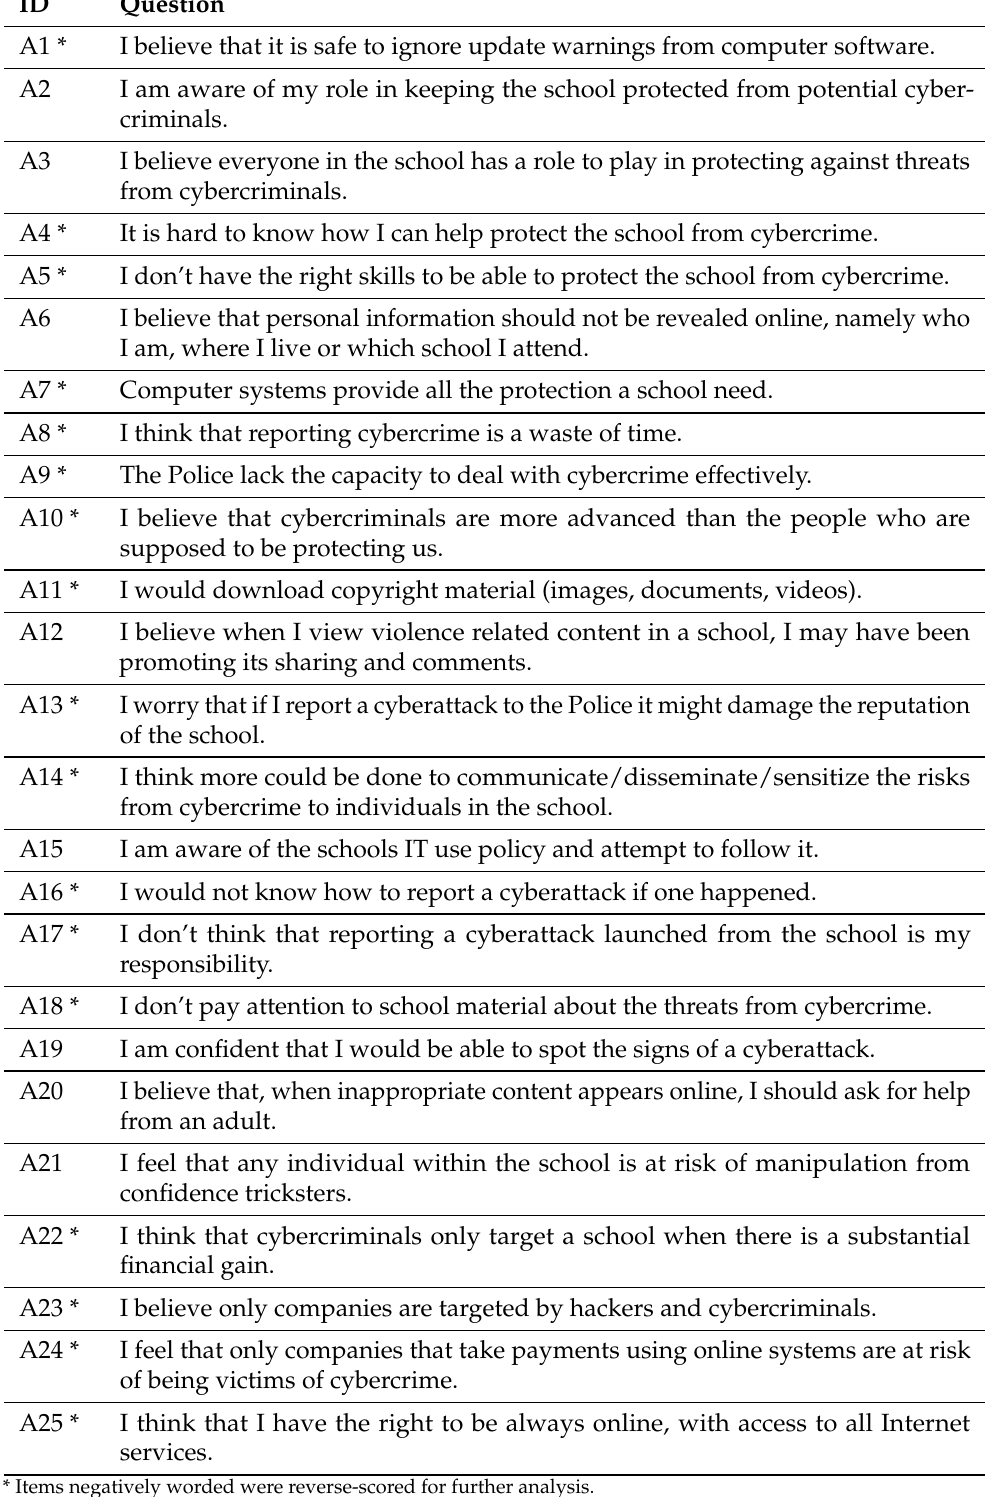
Table 1. Cybersecurity Attitudes in Schools